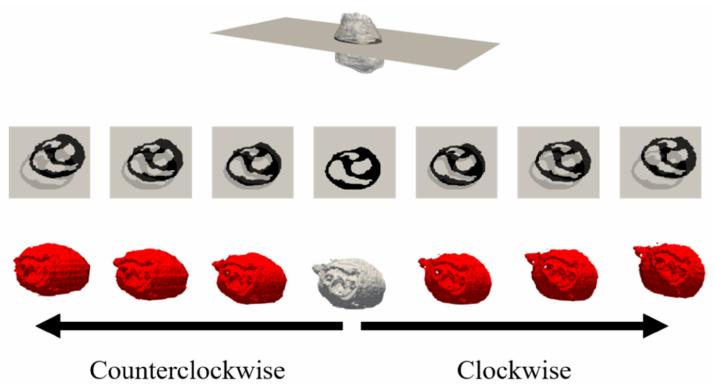
Figure 8. Variations of TARO cardiac model: rotation with ± 2, ± 5, and ± 10 degrees displayed in ascending order from left to right. Upper images are axial cross-sectional slices, and bottom images are volume renderings.